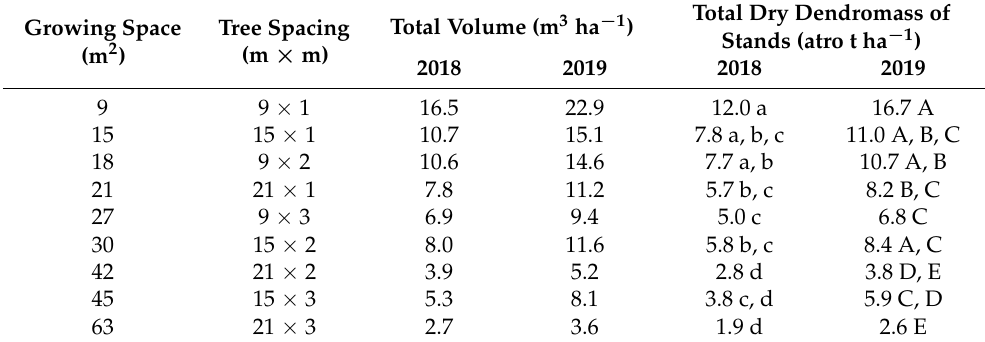
Table 3. Total volume and total above-ground dry dendromass of black locust stands per hectare in alley cropping systems in 2018 and 2019 according to the growing spaces ( α = 0.05; 2018: n = 272; 2019: n = 263).